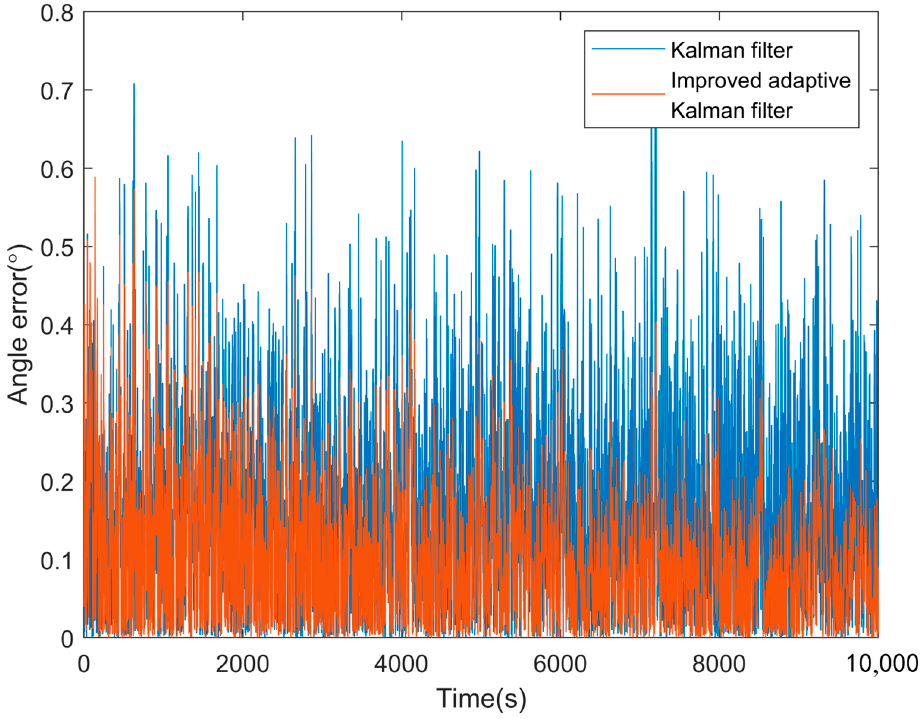
Figure 10. IAKF of the parallel four-bar linkage rotation angle filtering error.